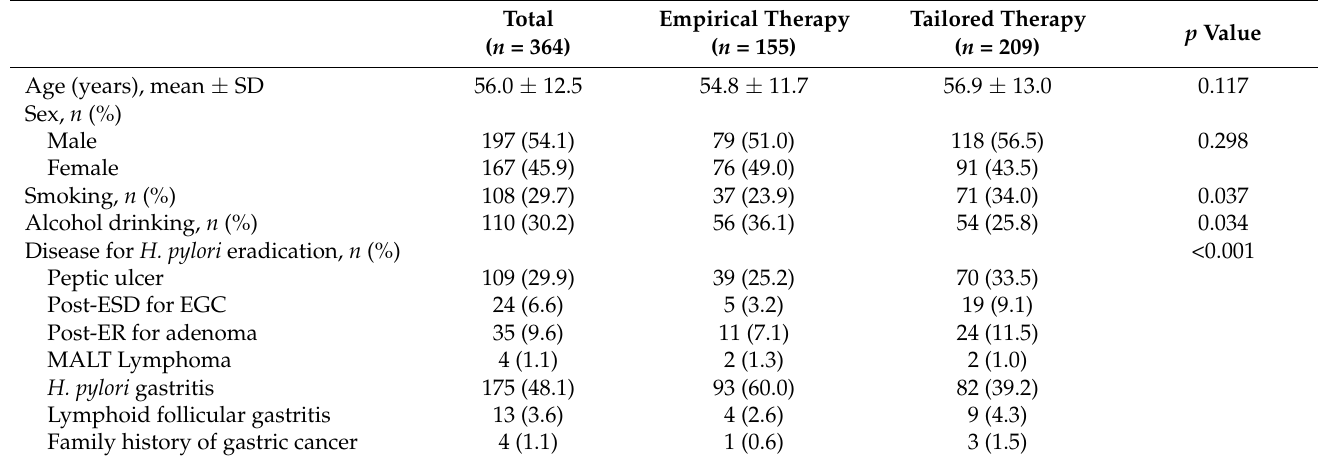
Table 1. Baseline characteristics of empirical and tailored therapy groups.